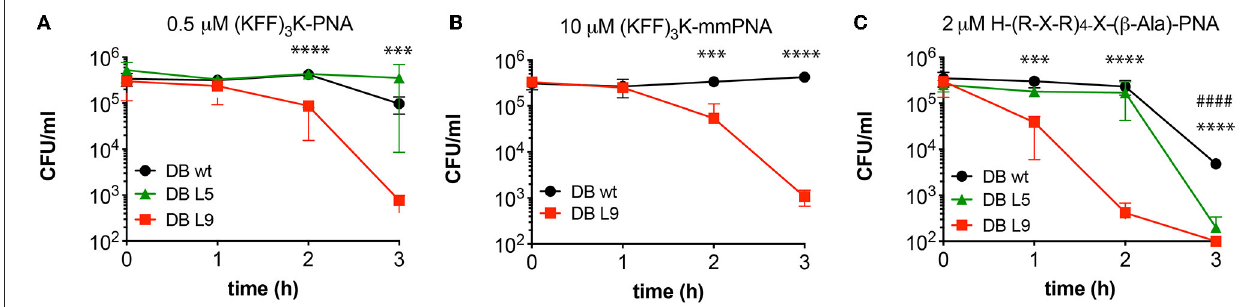
FIGURE 1 | The effect of O16 antigen restoration on BPP-PNA susceptibility. The O-antigen restored strain DB L9 was compared with the O-antigen deficient MG1655 parent strain with respect to survival upon BPP-PNA treatment at concentrations bordering the MIC. Approximately 5 × 10 5 cfu/ml were treated with BPP-PNA conjugates at the MIC value for up to 3h. Every hour, samples were collected and plated on LB-agar to assess bacterial survival. Colonies were enumerated following overnight incubation. Time-kill curves of (KFF) 3 K-PNA match (A) , and (KFF) 3 K-PNA mismatch (B) and H-(R-X-R) 4 -X-( β -Ala)-PNA (C) on E. coli strains DB wild type (MG1655, no O-antigen), DB L5 (partly restored O-antigen), and DB L9 (O16 antigen). Experiments were performed in triplicates and data are represented as the mean ± SD. P -values were determined by Student’s t -test comparing DBwt and DB L9 (*) or DBwt and DB L5 (#) (*** p < 0.005, **** p < 0.001, #### p <